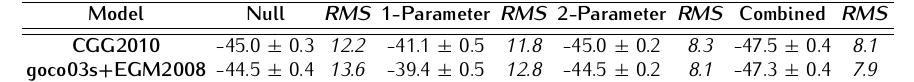
Table 5. Estimated LVD offset (cm) with various bias corrector models and their respective RMS of adjusted geoid height differences (cm).